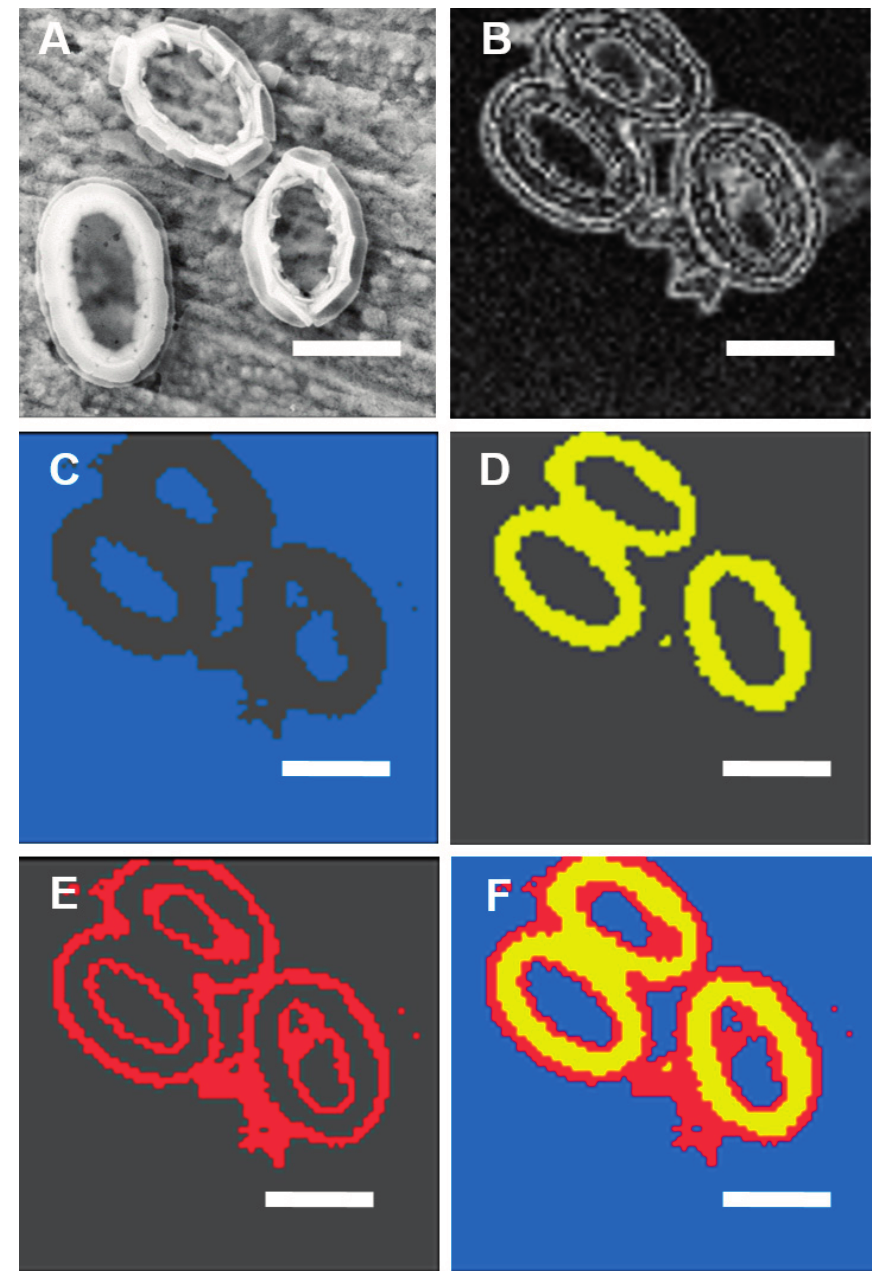
Figure 5. High-resolution (50 nm) spatial distribution of total Ca in P. carterae determined by STXM-NEXAFS spectromicroscopy. ( A ) Coccoliths image using FE-SEM; ( B ) Contrast tomography image; ( C ) Cluster 1 of background with blue color; ( D ) Cluster 2 of Ca form with yellow color; ( E ) Cluster 3 of Ca form with red color; ( F ) Merged images of ( C – E ). Scale bars: 2 μ